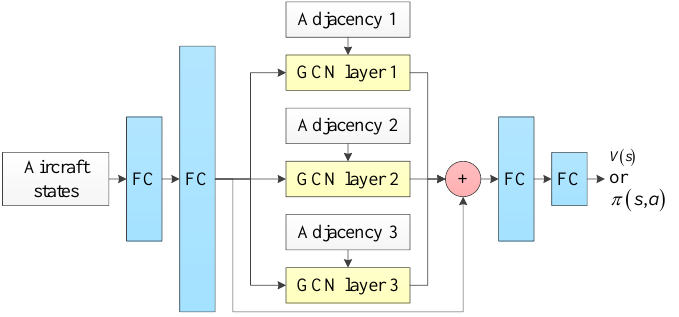
Figure 11. Neural network architecture with graph convolutional layers. Reprint from [38]. Message Passing Neural Networks (MPNN) is a general framework for supervised learning on graphs [56]. A recommendation architecture for ATC that combines multi- agent RL and MPNN is proposed in [39]. Flights correspond to the nodes of a graph, and edges include features about their relative positions. Aircraft are modeled as the agents of a cooperative multi-agent system. The interactions between agents are represented in the form of a graph G = ( V , E ) , where each node in V corresponds to one agent in N . The edges of the graph indicate which agents can communicate, and they include some features relative to the two agents that they connect. At every time step, each agent observes its state and encodes it into a hidden state. Then, agents start the message passing phase composed of several communication rounds. After the message passing phase, the probability distribution over all possible actions for each agent is generated. Finally,